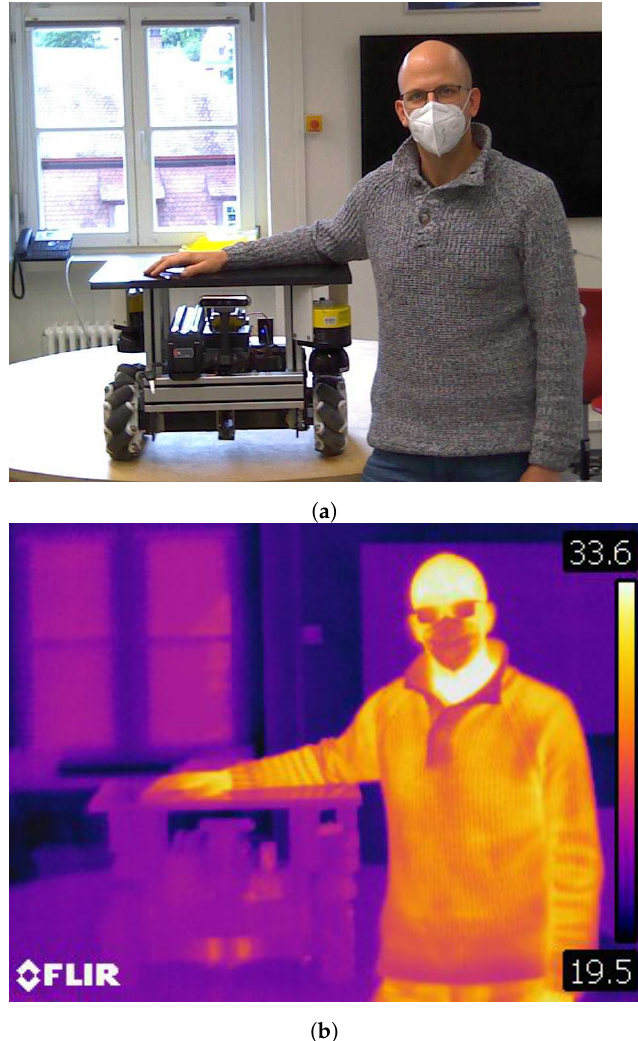
Figure 1. Comparison of visual and thermal image of a human next to an AGV. ( a ) Visual image; ( b ) Thermal